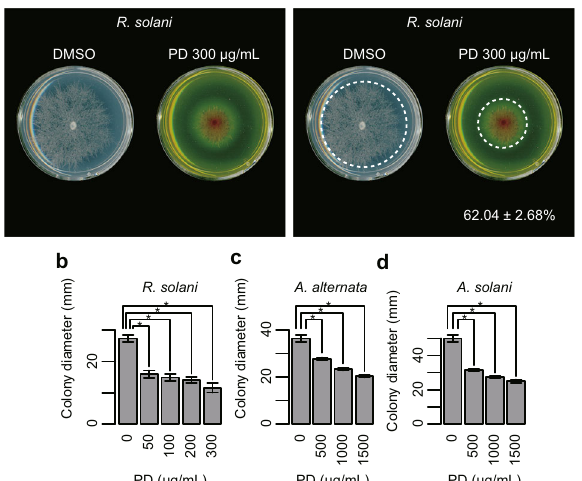
Fig. 9 Sensitivity of oomycetes and phytopathogenic fungi to poacidiene. a The effects of poacidiene (PD) on the growth of the oomycete P. aphanidermatum at 300 µg/mL. The radial growth of mycelia was tested ( n = 3) after 15 h, and PDA plates containing DMSO were used as control plates. The percentage and ± standard error of the growth inhibition by PD ( n = 3) was estimated by maximum likelihood estimation of one-way ANOVA assuming gamma distribution to colony diameter compared with the growth on the control plates ( n = 3). The images with and without a dotted circumference are shown after enhancing the contrast. The raw images are shown in Supplementary Fig. 5. The dose-dependent inhibition of b P. aphanidermatum after 15 h and c P. sojae by PD. Asterisks in ( b ) P. aphanidermatum indicate a signi fi cant difference at p < 0.01 by Dunnett ’ s test. Error bars indicate standard deviations. The regression curve in ( c ) P. sojae was estimated by maximum likelihood estimation of multiple linear regression analysis assuming negative binomial distribution to colony diameter (mm, n = 72) with the cultivation time (day) and the concentration (µg/mL) of the PD treatment as explanatory variable ( p = 4.39e − 23 by likelihood ratio test). Black, brown, red, and orange lines and dots indicate 0, 500, 1000, and 1500 µg/mL of PD.